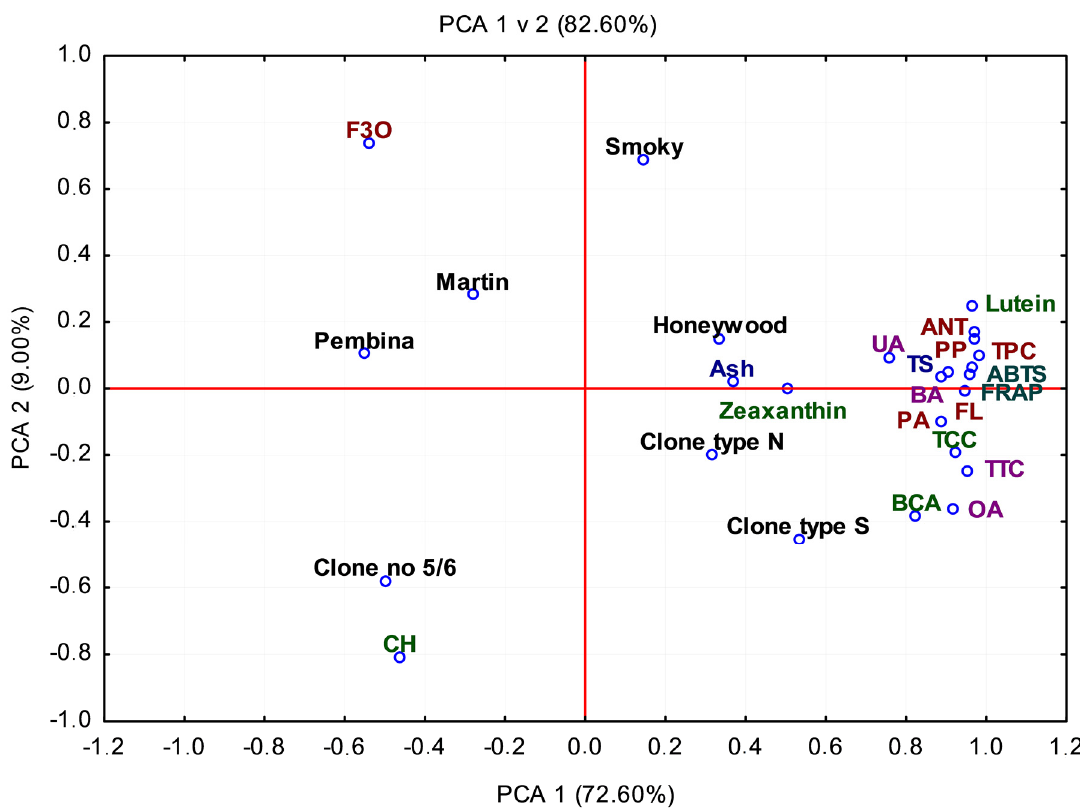
Figure 3. PCA mean showing the relationship among phytochemical compounds and antioxidant activity in fruits of the Saskatoon genotypes grown in Poland. UA, ursolic acid; OA, oleanolic acid; BA, betulinic acid; FL, flavonols; ANT, anthocyanins; PA, phenolic acid; F3O, falavan-3-ols; BCN, beta-carotene; CH, chlorophylls; TS, total sugar; TCC, total carotenoids compounds; TTC, total triterpenoids compounds; PP, polymeric procyanidins.